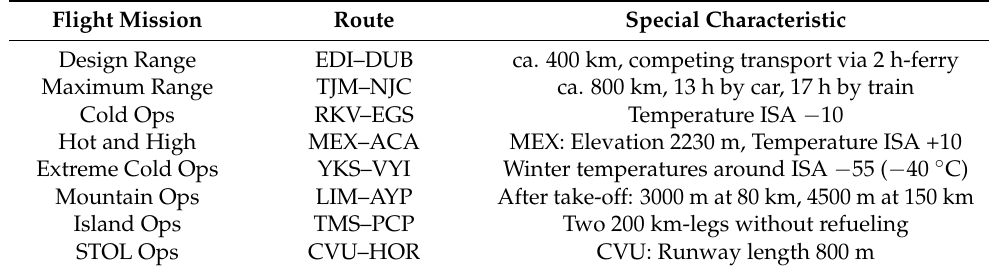
Table 5. Selection criteria for chosen flight